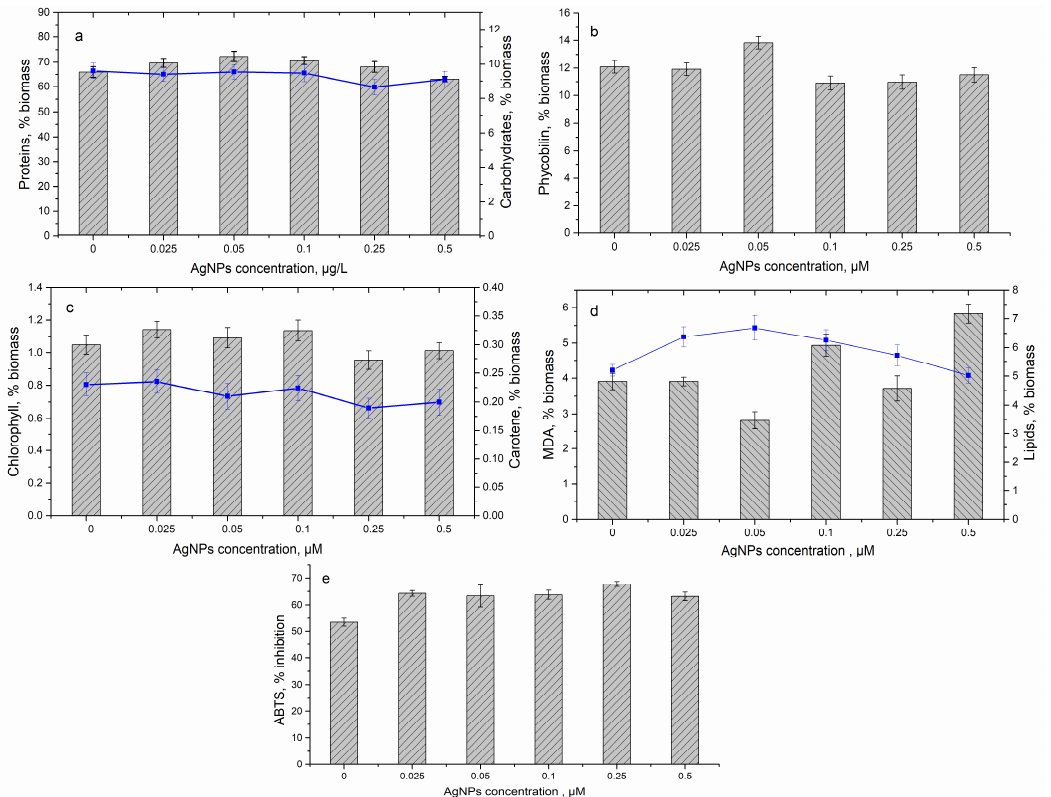
Figure 4. Change of ( a ) proteins and carbohydrates, ( b ) phycobilins, ( c ) β-carotene and chlorophyll a, ( d ) lipids and MDA content, and ( e ) antioxidant activity of hydric extract in Spirulina platensis biomass at the introduction of AgNPs in culture medium in concentration range 0.025–0.1 µM.